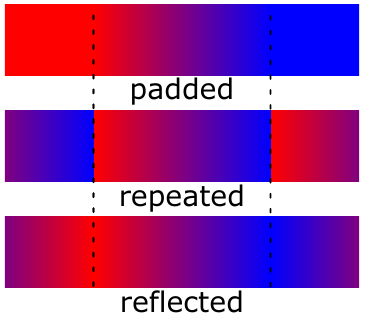
Figure 1: example of different SVG spreadMethod